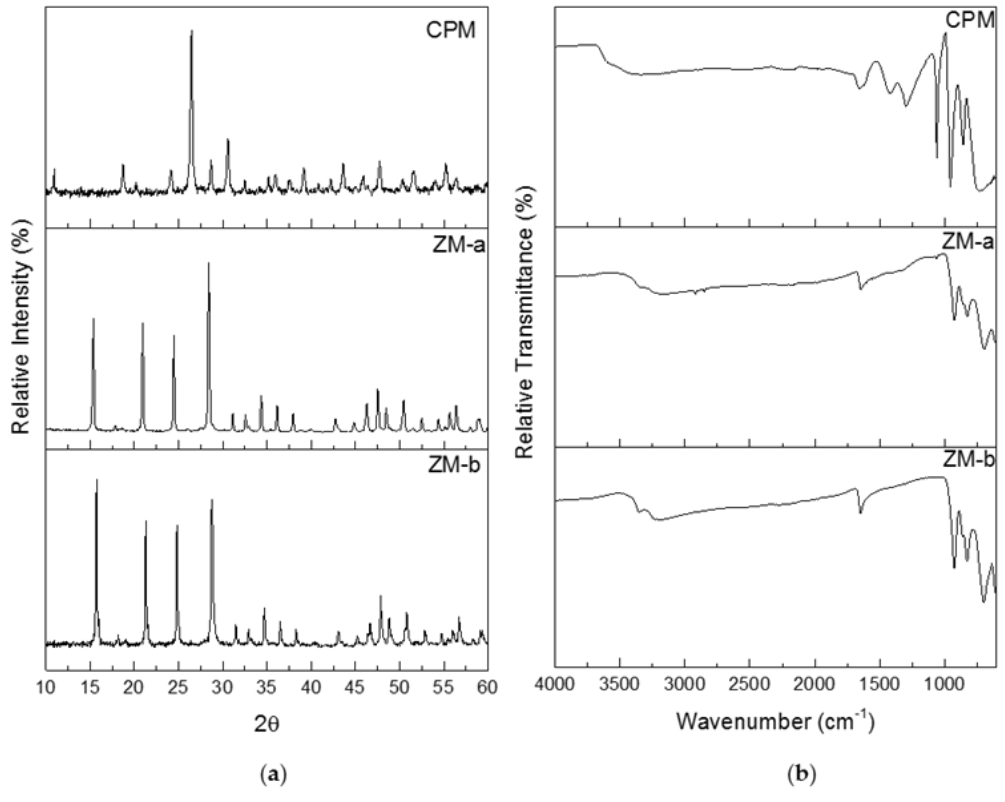
Figure 5. ( a ) Powder X-ray Diffraction patterns for caesium phosphomolybdate synthesised at 50 °C (CPM), and zirconium molybdate (ZM-a and ZM-b). ( b ) Infrared spectra of CPM synthesised at 50 °C, ZM-a and ZM-b.